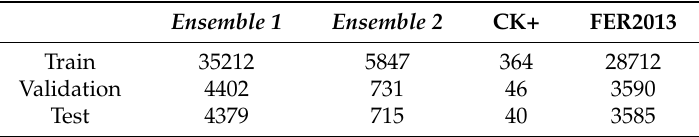
Table 2. Subdivision of the databases.